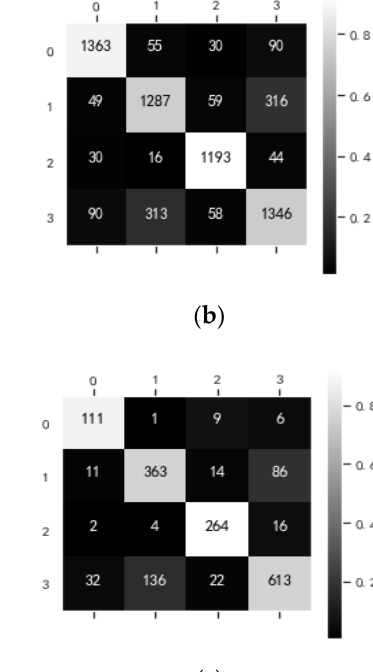
Table 13. Parameters of Random Forest2. Parameters